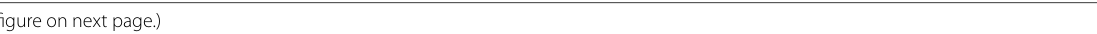
figure on next Fig. 3 NAC relieves COPD-induced pulmonary fibrosis by inhibiting VWF. A Efficiency of VWF overexpression detected by RT-qPCR. COPD rats were treated with NAC and oe-VWF (with NAC and oe-NC as control) (n 10). B VWF expression in lung tissues of COPD rats detected by RT-qPCR. = C Levels of IL-6 and TNF-α in the serum of COPD rats measured by ELISA. D Histological score of COPD rats detected by HE staining. E Bronchioles area, thickness bronchioles, the wall area/total bronchiole area (MA%) and the wall thickness/bronchiole diameter (MT%) of COPD rats; F Collagen volume fraction in lung tissues of COPD rats detected by Masson’s trichrome stain. G α-SMA level in lung tissues of COPD rats detected by Immunohistochemistry. CSE cells were transduced NAC and oe-VWF (with NAC and oe-NC as control). H VWF expression in CSE cells detected by RT-qPCR. I Levels of IL-6 and TNF-α in CSE cells measured by ELISA. J Protein levels of Collagen I and α-SMA in CSE cells determined by Western blot analysis. ** p < 0.05. *** p < 0.001. **** p < 0.0001. Data are shown as the mean standard deviation of three technical replicates. Data between two ± groups were compared by independent sample t test. Data among multiple groups were compared by one-way ANOVA with Tukey’s post hoc